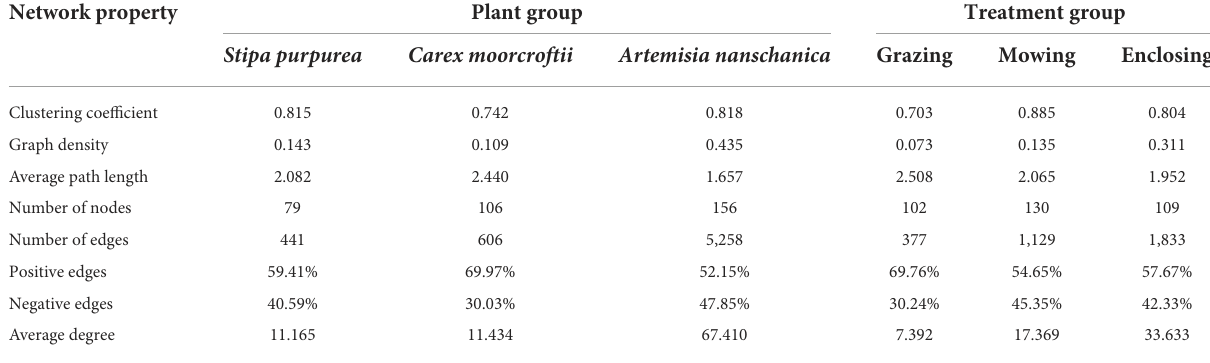
TABLE 4 Topological index of rhizosphere soil microbial community interaction network among different plants and different utilization patterns. Network